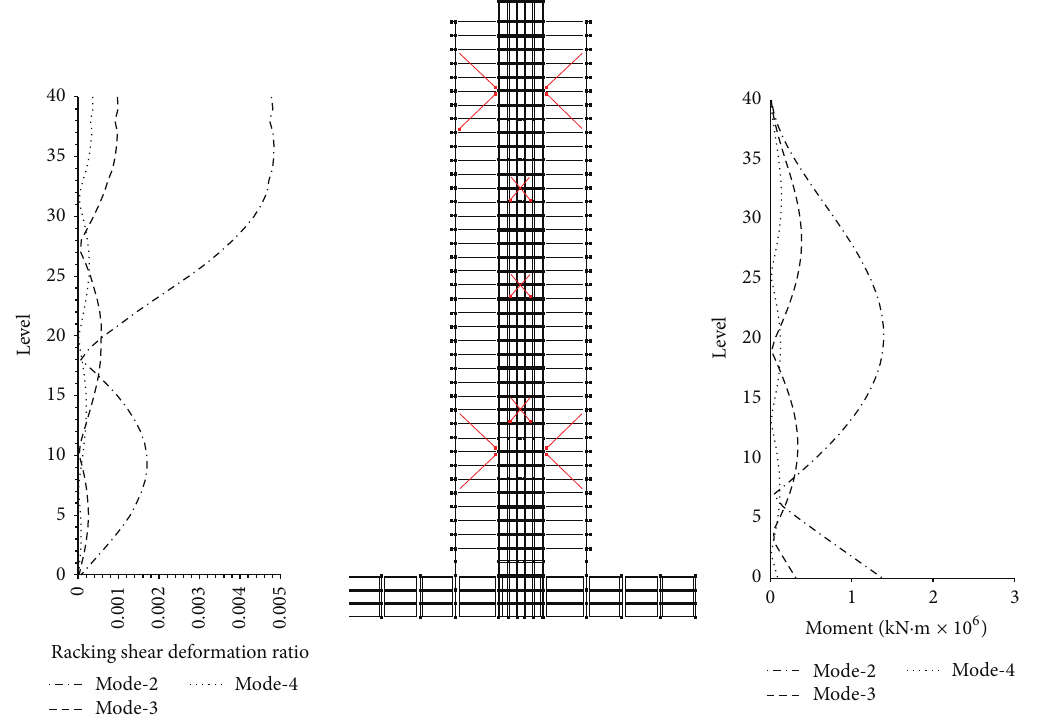
Figure 8: Arrangement of the exterior BRBs at locations of maximum DBE elastic racking shear deformation in 2nd and 3rd mode and interior BRBs at locations of maximum DBE elastic moment demands in 2nd and 3rd mode